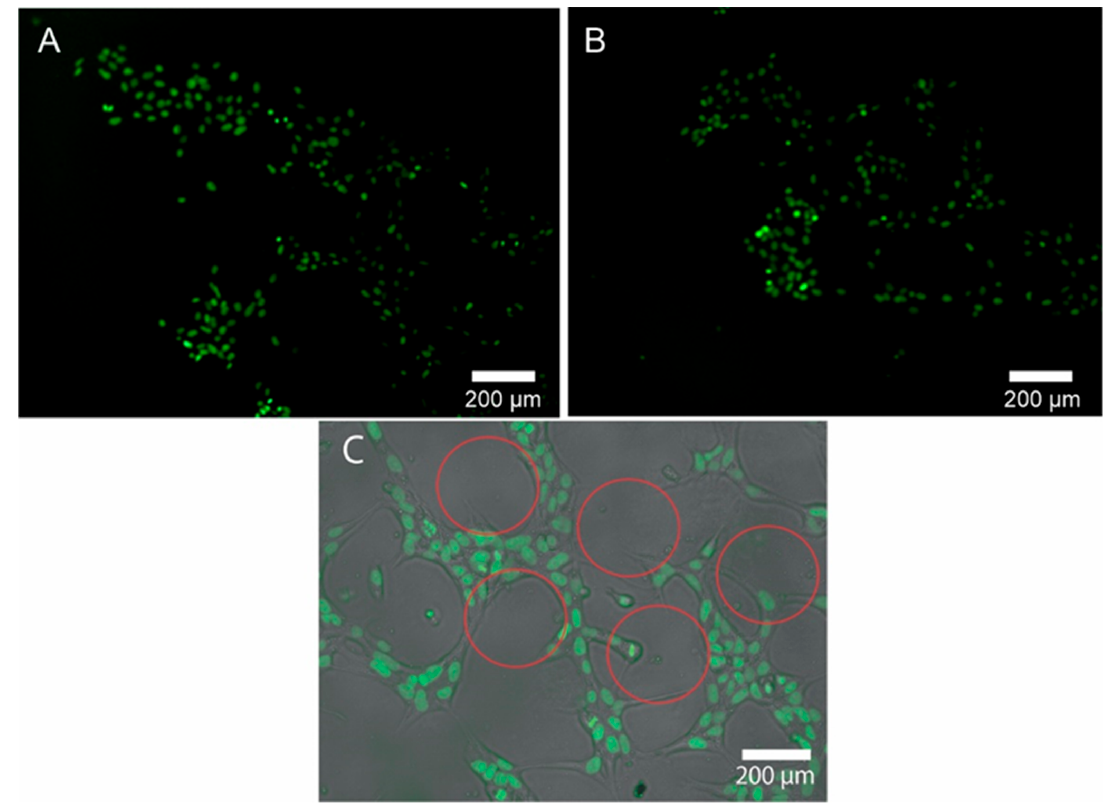
Figure 4. ( A ) Adhered hiPSC cells in the pattern printed on the culture plate. ( B ) Cells attached to a pattern of different heights with higher cell densities after 12 h of incubation. ( C ) Brightfield and overlay layer that show how the cells follow only the segment where the pattern was printed. Red outlines show the dots of the patterns created by the microcontact printing technique; the cells grew around the